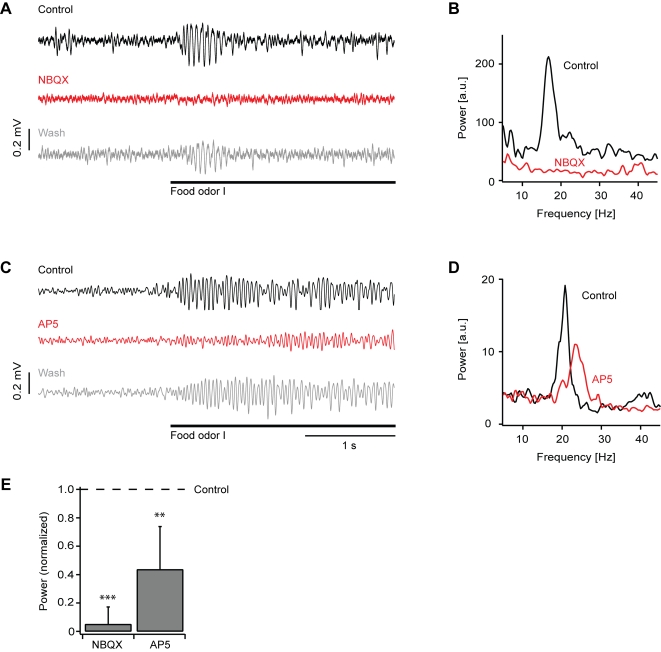
Effect of NBQX and AP5 on local field potential oscillations.(A) Example of a local field potential recording (bandpass-filtered 8–43 Hz) of an odor response (food odor; bar) before (black) and during application of NBQX (red) and after washout (gray). (B) Example of power spectra of local field potential responses before and during application of NBQX (average of 7 trials; calculated from unfiltered traces). (C) Example of a local field potential recording of an odor response before and during application of AP5 and after washout. (D) Example of power spectra before and during application of AP5 (average of 14 trials; calculated from unfiltered traces). (E) Average local field potential power (15–30 Hz) in the presence of NBQX (n = 6 olfactory bulbs) and AP5 (n = 4 olfactory bulbs), normalized to control. ***, P<0.001; **, P<0.01.